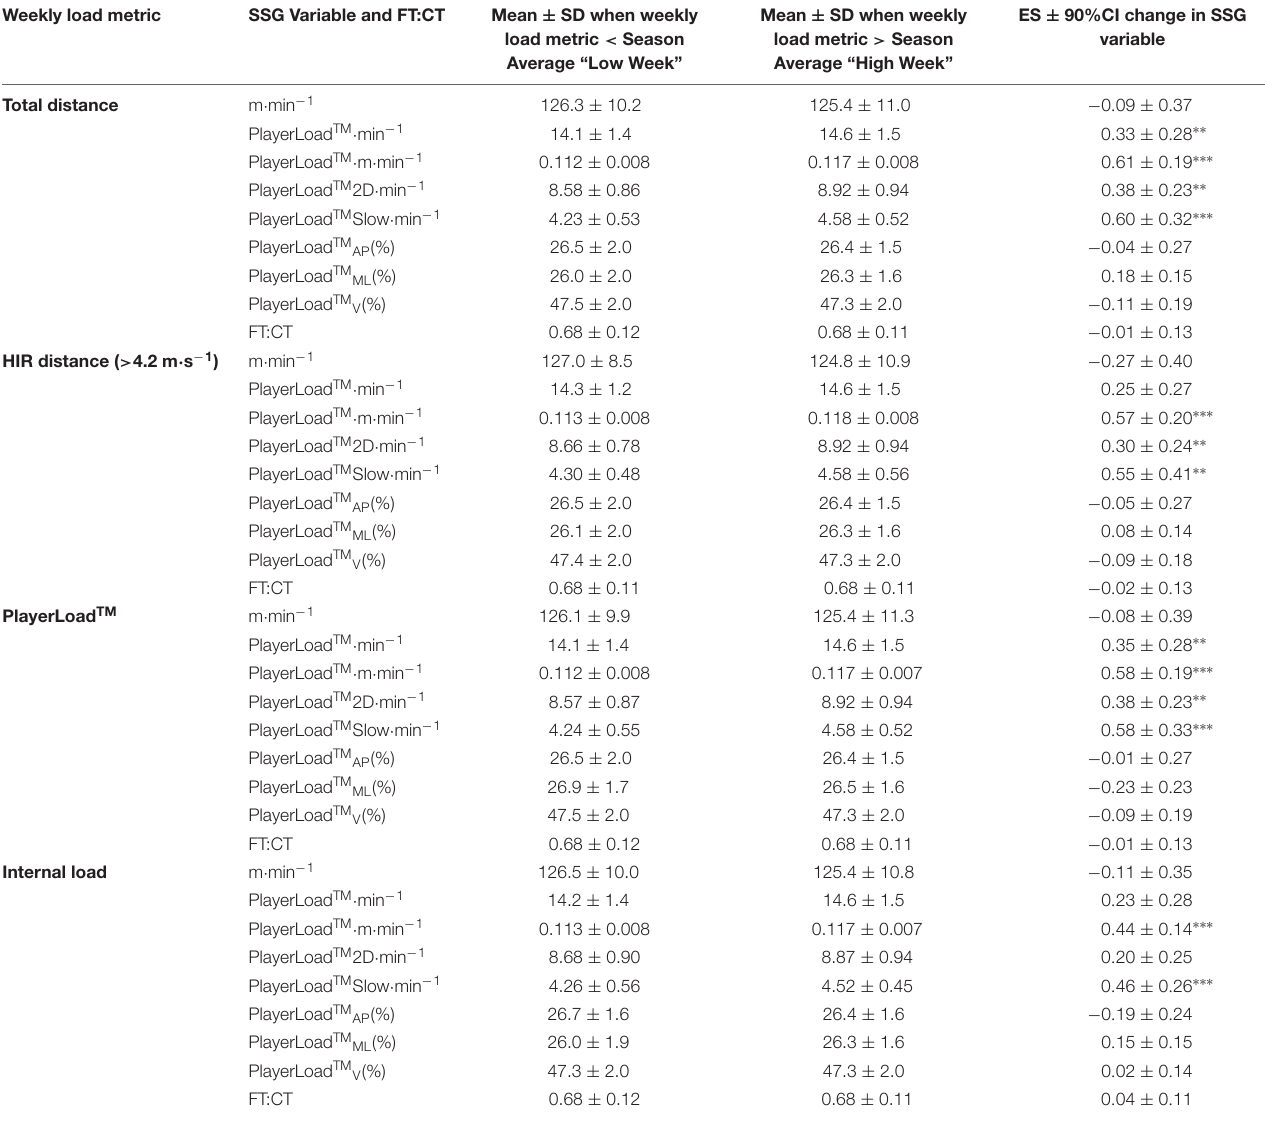
TABLE 2 | Mean ± SD and change in mean (ES ± 90% CI) in selected small-sided game; SSG activity metrics when weekly load variable was higher than the season average. Weekly load